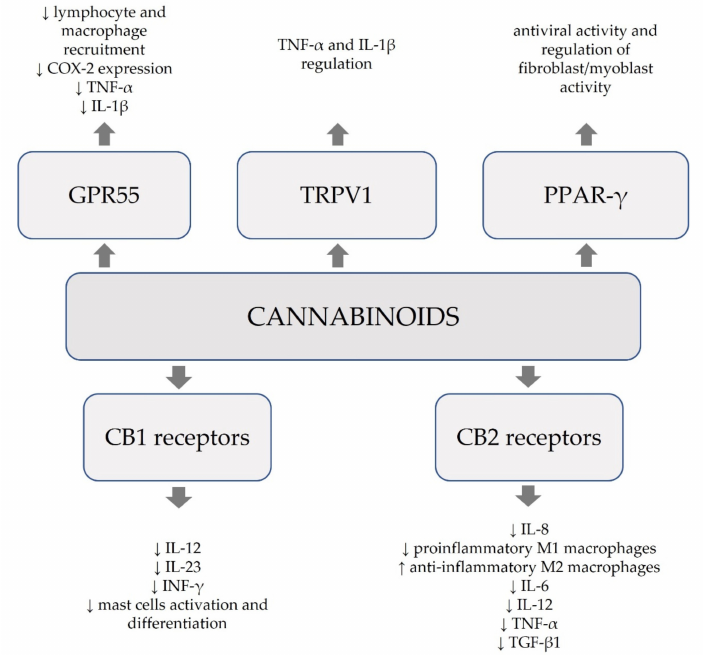
Figure 2. Anti-inflammatory, immunological, and antioxidative modes of action of